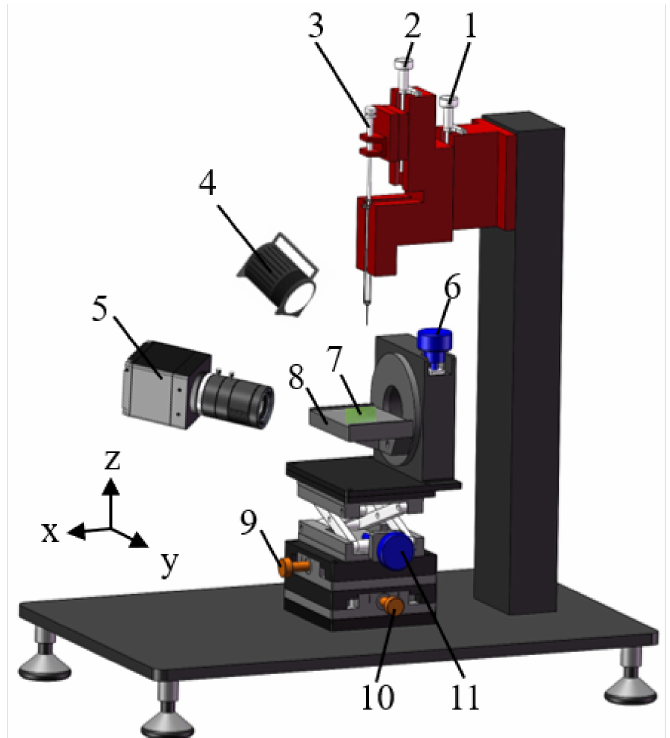
Figure 1. Dynamic impact test platform, 1. Height adjustment knob, 2. Droplet size adjustment knob, 3. Precision syringe, 4. Light source, 5. High-speed camera, 6. Angle adjustment knob, 7. Banana leaf sample, 8. Stage, 9. X axis adjustment knob, 10. Y axis adjustment knob, 11. Z axis adjustment